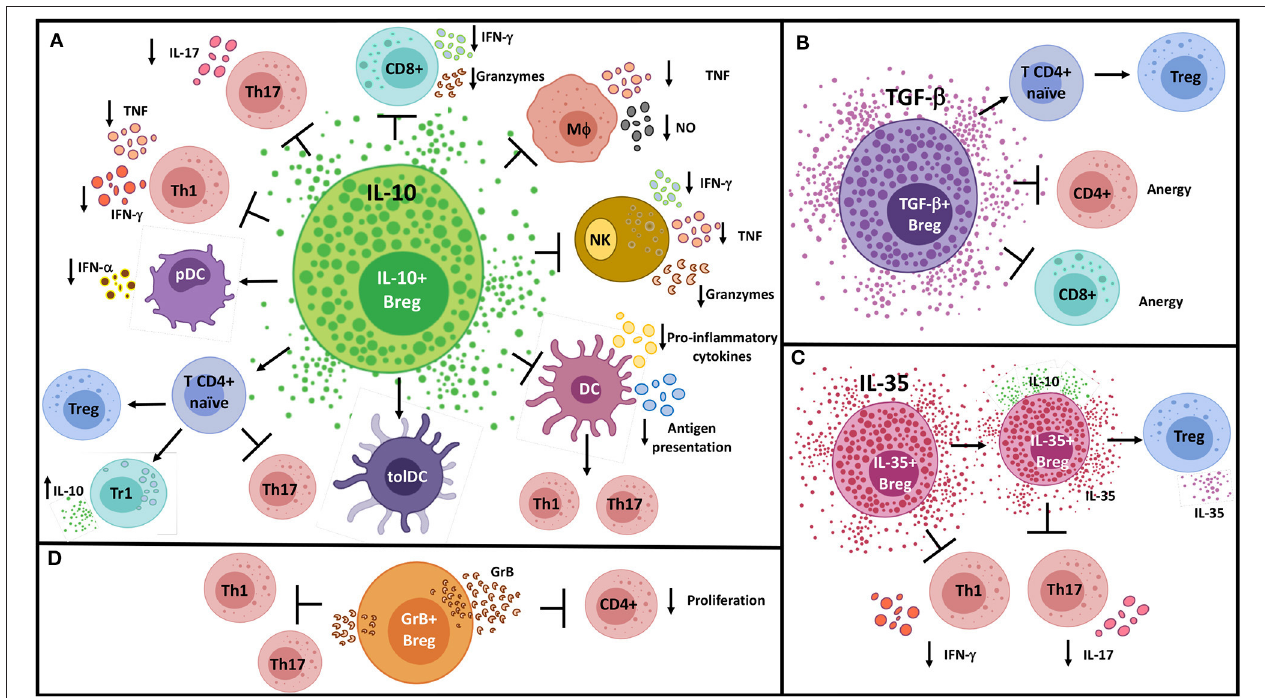
FIGURE 1 | Suppressive mechanisms of Bregs by soluble molecules. (A) IL-10 + Bregs inhibit Th1, Th17, and CD8 + T cell responses; convert naïve CD4 + T cells into regulatory T cell populations; and modulate pro-inflammatory innate cells through the production of IL-10. (B) Likewise, TGF- β + Bregs operate on naïve CD4 + T cells to generate FoxP3 + Tregs, in addition to induce anergy in CD4 + and CD8 + T cells. (C) IL-35 + Bregs can promote “infectious tolerance” by inducing IL-35-producing Tregs and expanding the generation of IL-35 + Bregs. (D) GrB + B cells have been shown to inhibit Th1 and Th17 cell responses and to reduce CD4 + T cell proliferation by degrading the TCR ζ -chain. DC, Conventional dendritic cell; GrB, Granzyme B; M Φ , Macrophage; NK, Natural killer cell; NO, Nitric oxide; pDC, Plasmacytoid dendritic cell; TolDC, Tolerogenic dendritic cell; Tr1, Type-1 regulatory T